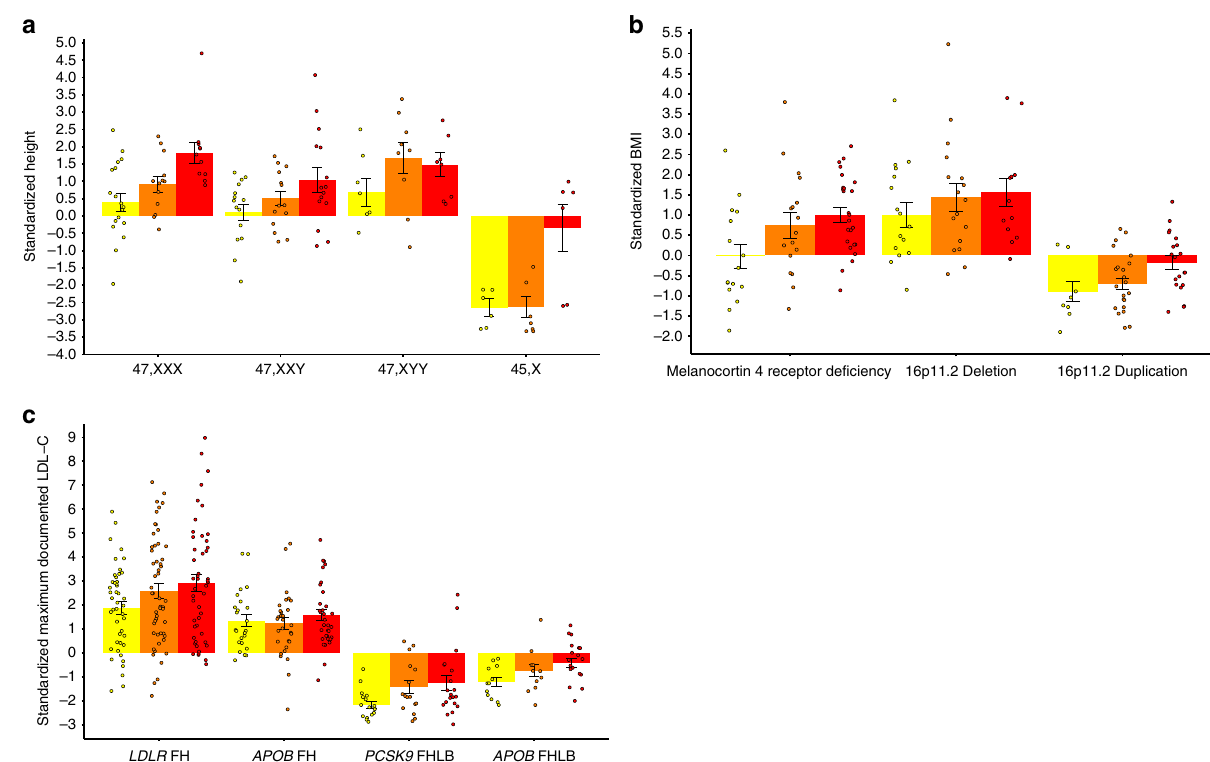
Fig. 2 Individuals with rare genetic disorders strati fi ed by PGS. Mean standardized height ( a ), BMI ( b ), and LDL-C ( c ) per tertile of the polygenic score within individuals with an RGD. Error bars indicate the standard error of the mean. Coloring of the bars and points yellow, orange, and red indicates a low, medium, and high polygenic score, respectively. FH Familial Hypercholesterolemia, FHLB Familial